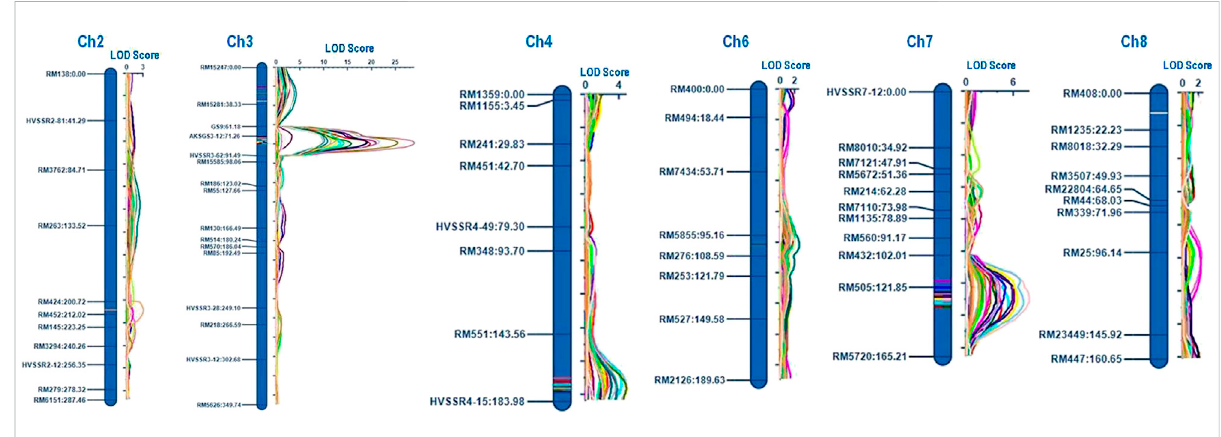
FIGURE 4 Graphical representation of identi fi ed QTLs on